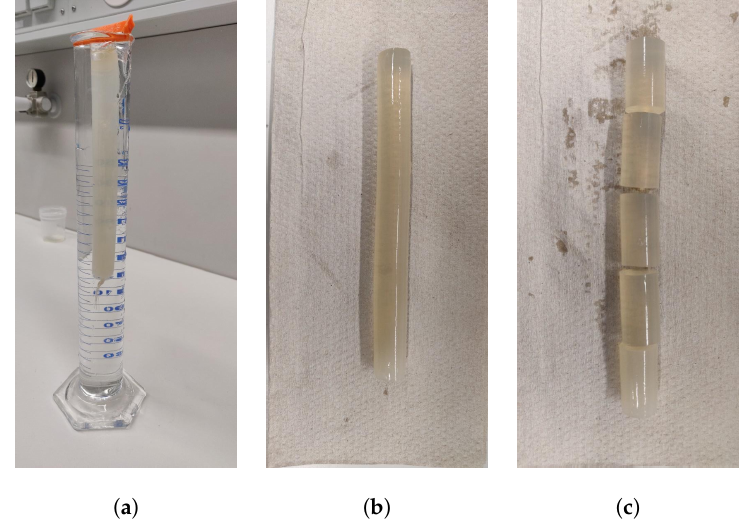
Figure 9. Preparation of cylindrical alginate gel ( a ); alginate gel removed from the dialysis tube ( b ) and cut into cylinders ( c